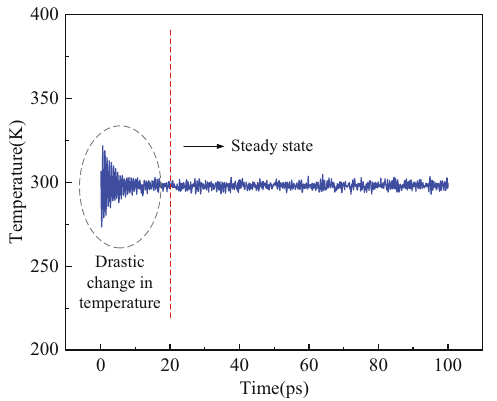
Figure 14: MSD fi tting results of interfacial di ff usion between asphalt and